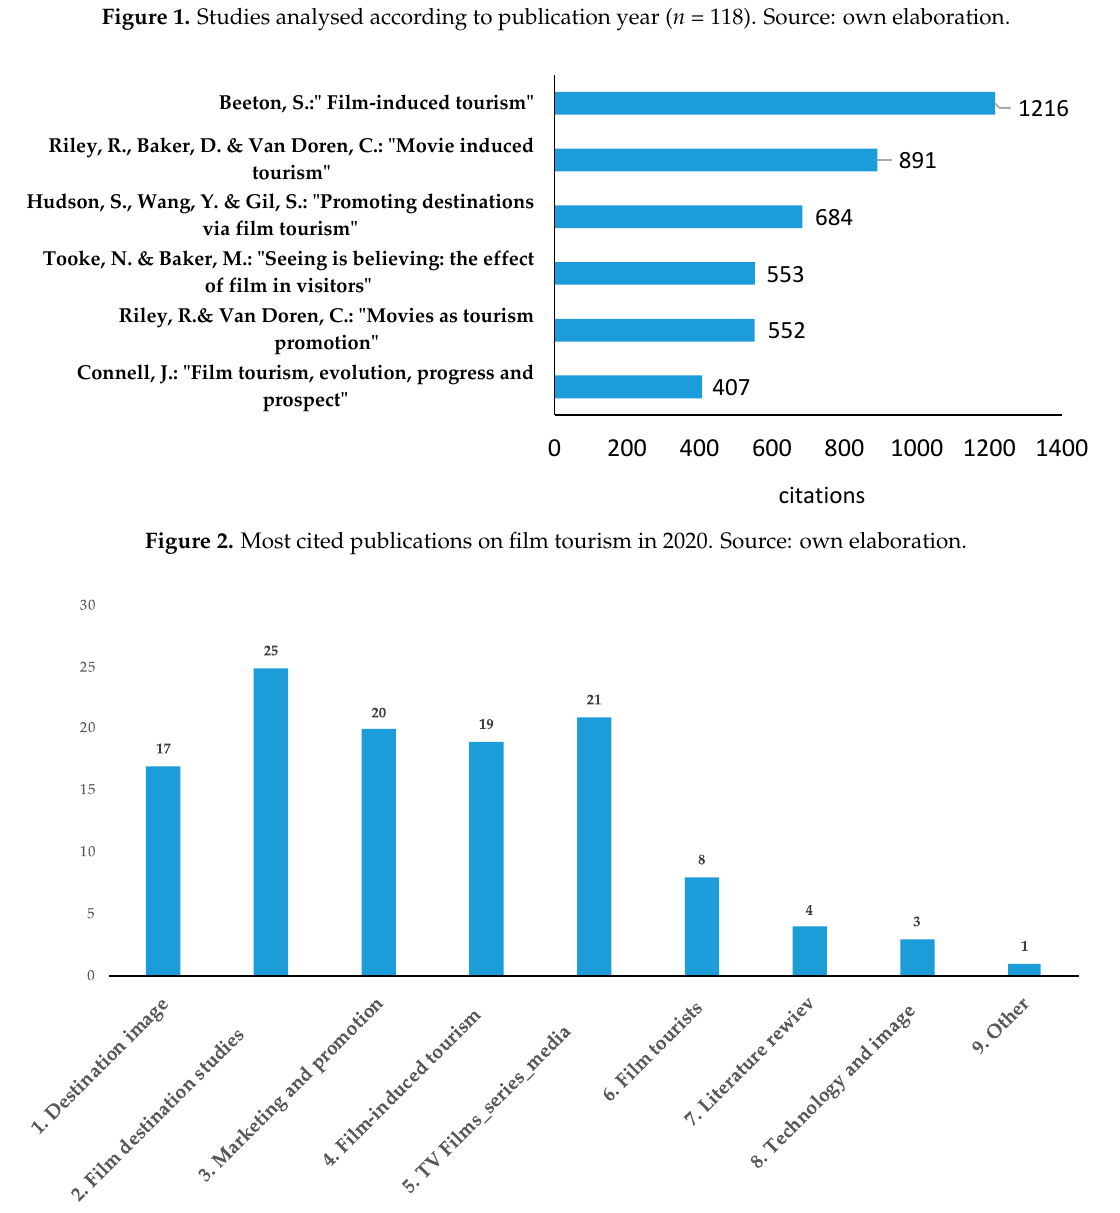
Figure 3. Main topics from the analysed literature ( n = 118). Source: own elaboration